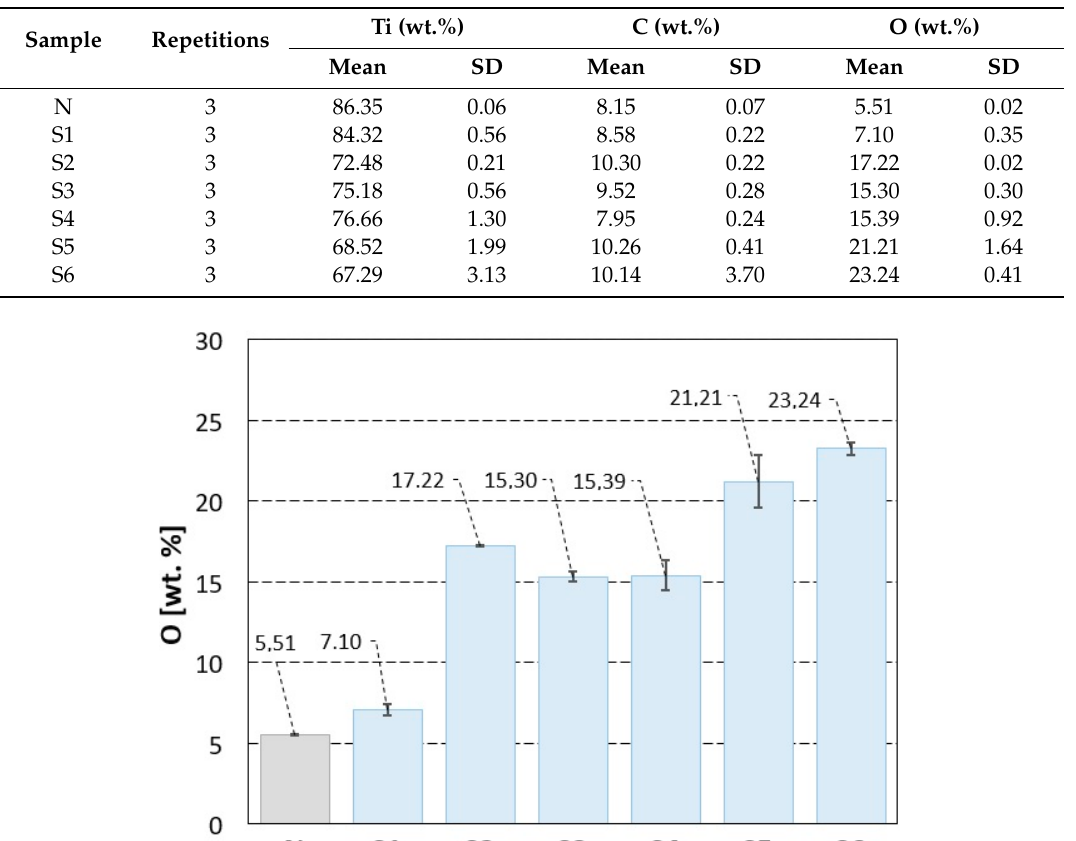
Figure 8. Weight percentage of oxygen content in the non-treated surface (N) and machined surfaces (S1–S6).